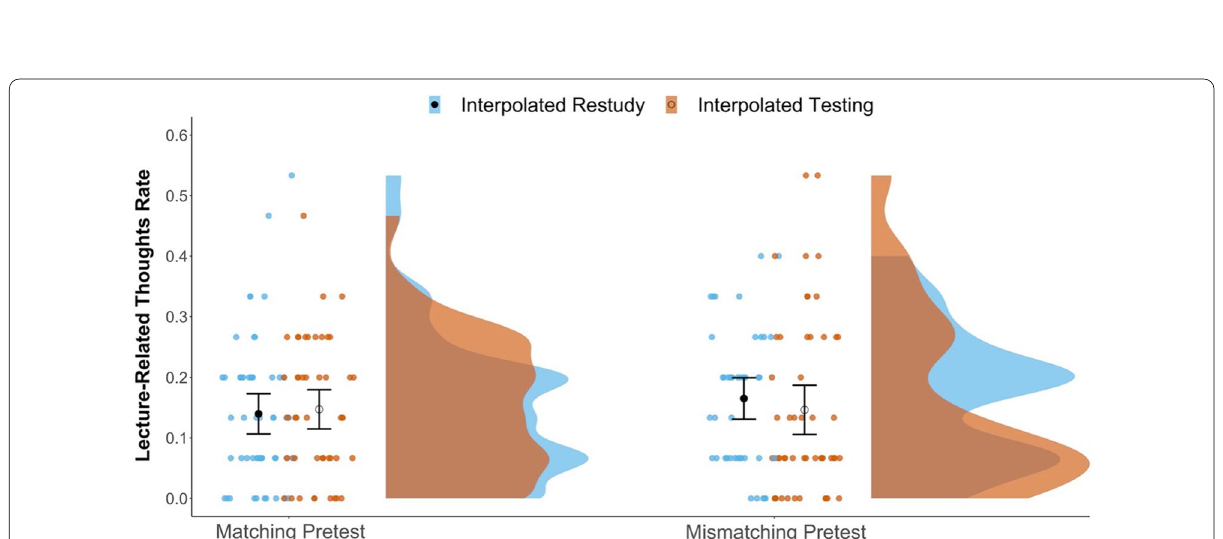
Fig. 5 Raincloud plots depicting the proportions of lecture-related off-task thought in each condition. Dots represent individual subjects’ rates. The closed black dots represent group-level mean estimates for the Restudy conditions; open circles represent the group-level mean estimates for the Testing conditions. Error bars are 95% confidence